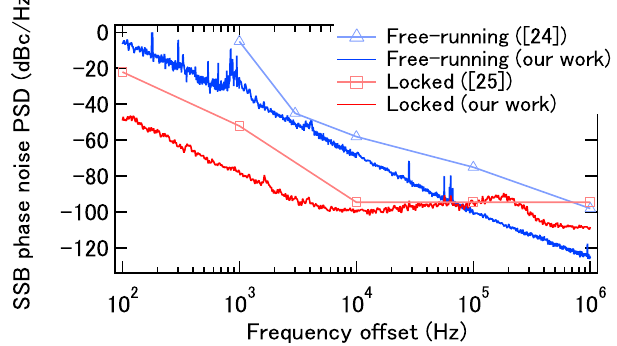
Fig. 6 Comparison with other Kerr combs scaled to 560 GHz. Single- sideband (SSB) phase noise power spectral densities (PSDs) of 560 GHz carriers generated from free-running Kerr combs reported in the ref. 24 (light blue triangle) and this work (red square). SSB phase noise PSDs of 560 GHz carriers generated from stabilized Kerr combs reported in the ref. 25 (light red curve) and this work (red curve). The phase noise shown by the blue curve is estimated from the measurement by a TWDI, instead of actually generating a 560 GHz carrier. When a 560 GHz carrier is generated, phase noise will see the white noise fl oor similar to the red curve. The red curve is sum of the two comb ( L rep1 ( f ) and L rep2 ( f )). Therefore, the phase noise of a single 560 GHz carrier would be a few dB